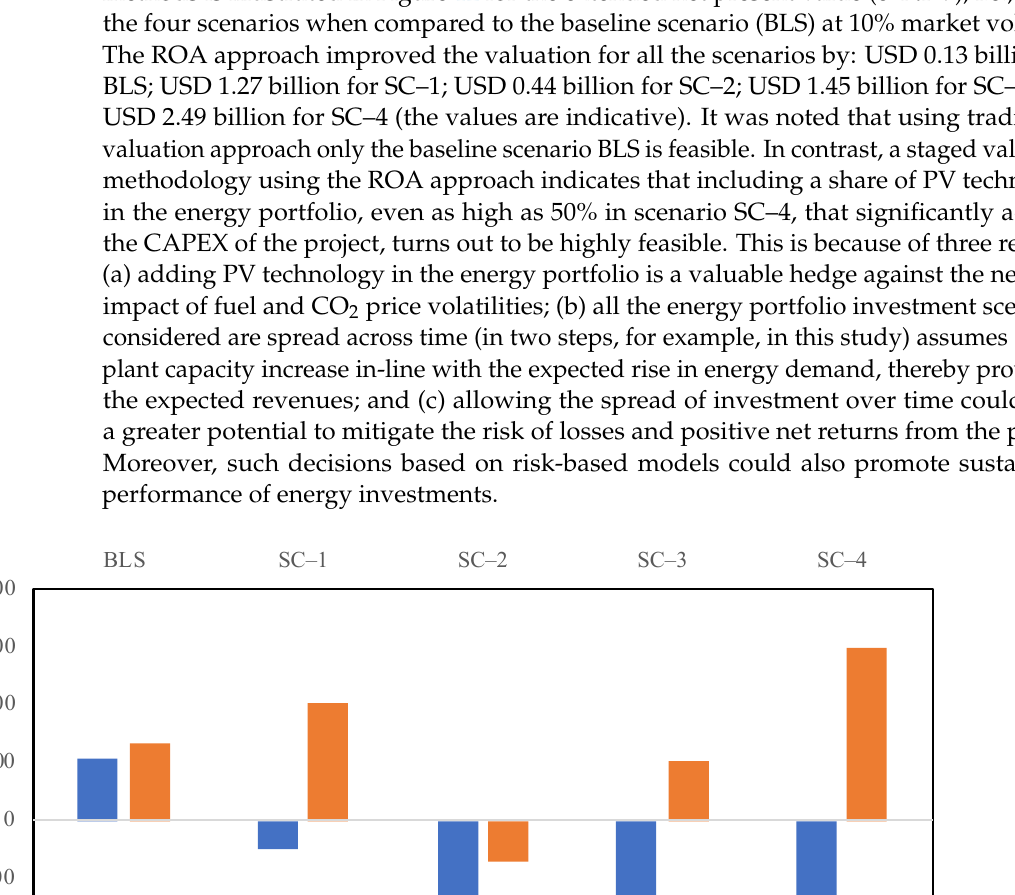
Figure 11. Binomial lattice model for the highest future value node of SC–1 expansion configuration (Million USD).